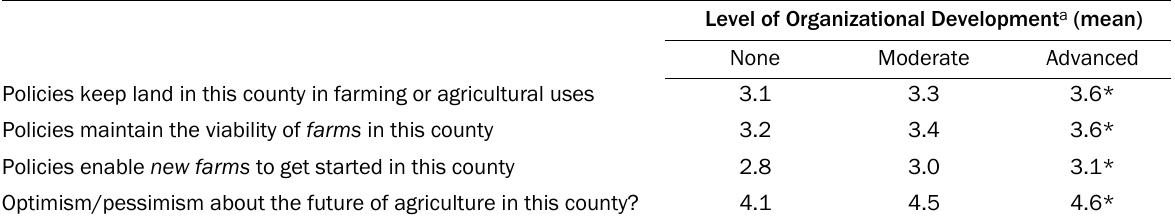
Table 7. Policy Impacts and Perceived Optimism by Level of Organizational Development